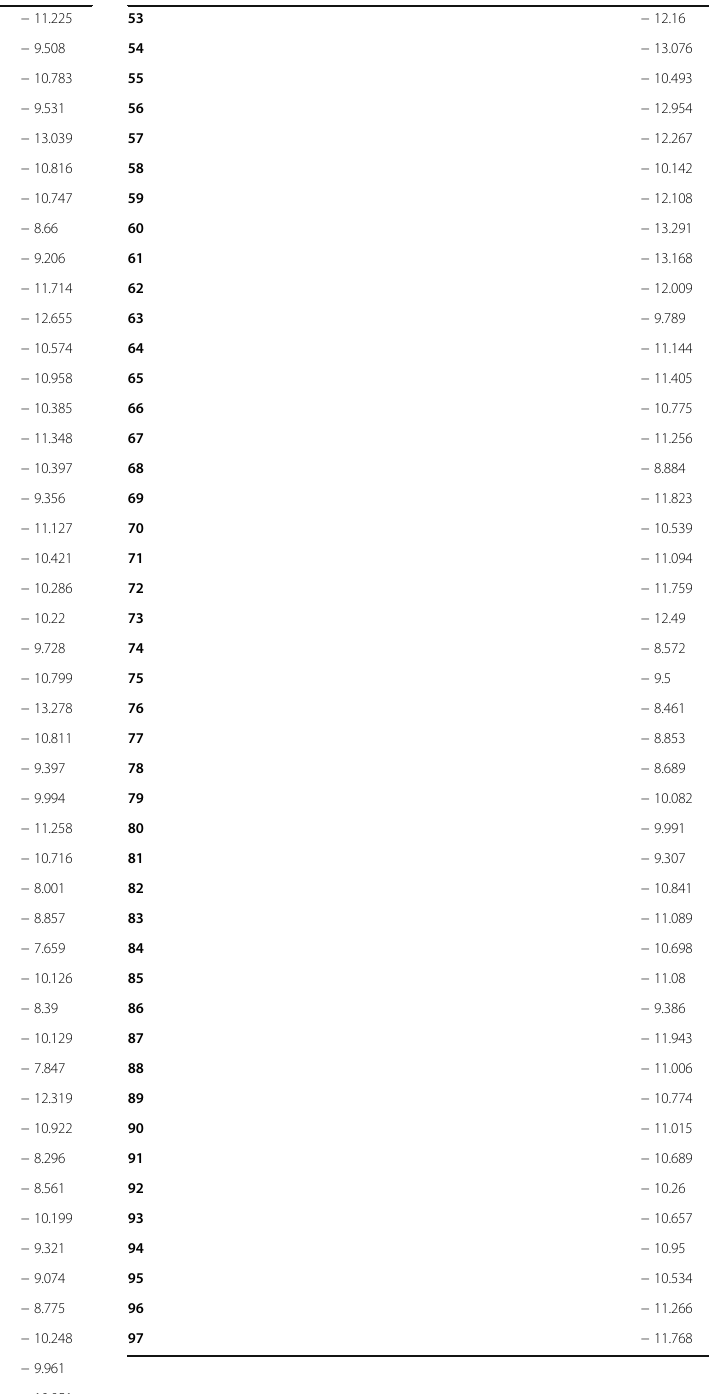
Table 4 Docking score of compounds (Kcal/mol)